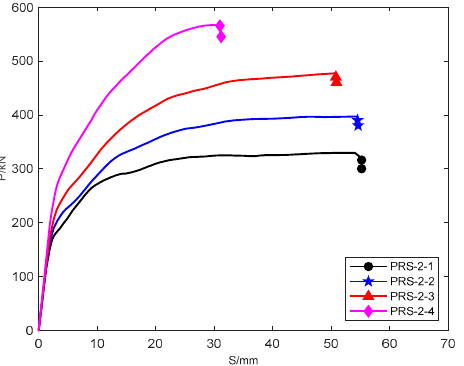
Figure 15. Effect of prestressed steel strand on mid span deflection curve.